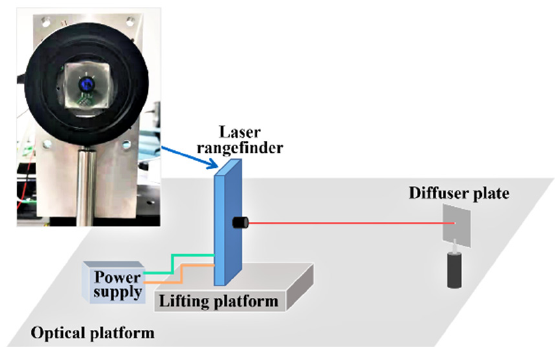
Figure 4. The gray-value distance correction experimental platform.